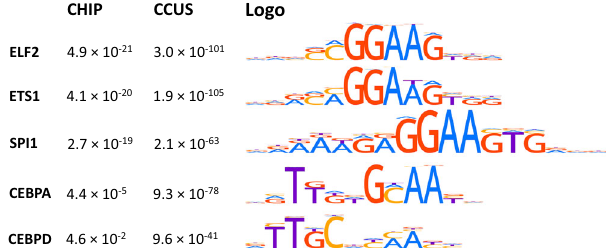
Fig. 4 Selected enriched transcription factor binding motifs at hypermethylated monocyte enhancer regions in CHIP and CCUS. Hypermethylated regions de fi ned as 200 bp fl anking regions around CpG sites located in an enhancer region. Enrichment (E) values derived using the Fischer ’ s exact test method in Analysis of Motif Enrichment. E values are adjusted P values with correction for the number of tested transcription factor binding motifs from the HOCOMOCO v11 full dataset ( N =